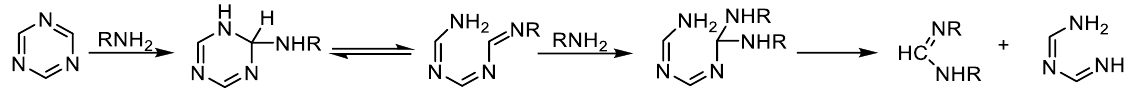
Scheme 1. The ring cleavage of s -triazine by primary amines.